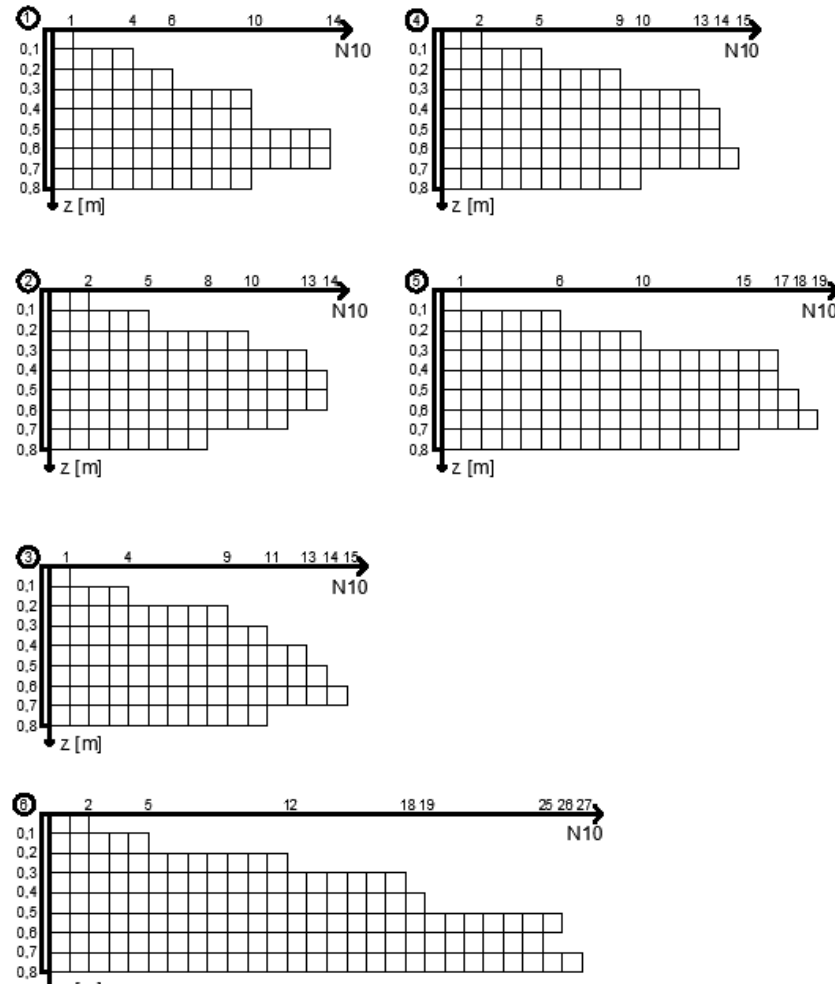
Figure 6. Diagrams of the N 10 , number of impacts necessary to achieve 10 cm of displacement, for each pile during installation. pile during